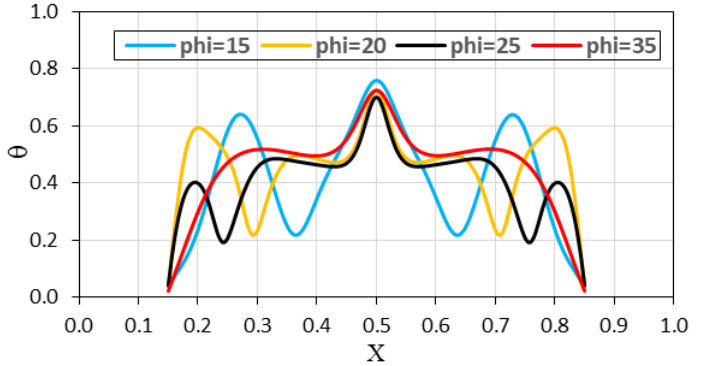
Fig. 9. Temperature along horizontal line at Y= 0.5H of the roof pitch